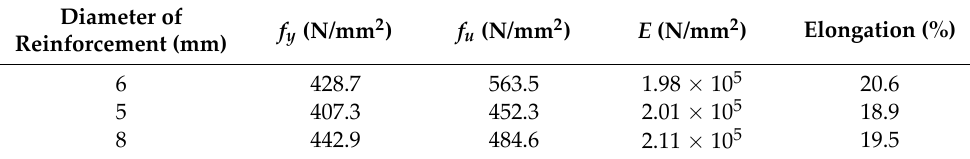
Table 1. Material properties of